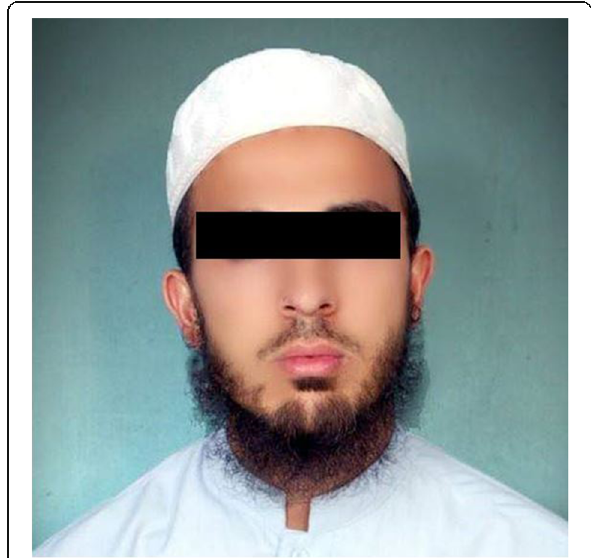
Fig. 3 The swelling subsided with no residual signs of infection or